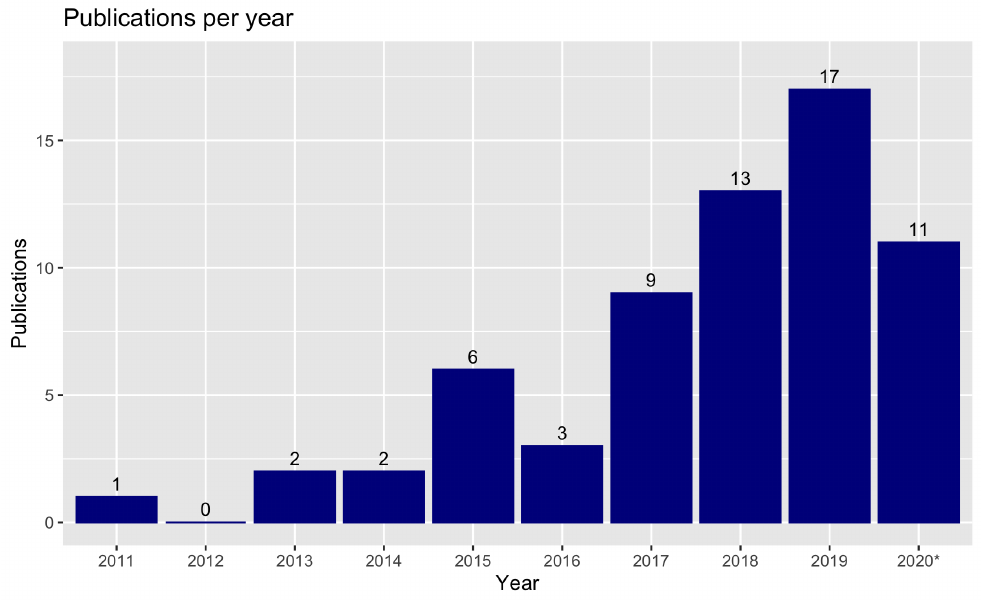
Figure 11. Related publications per year. The year of 2020 was evaluated from January until November.